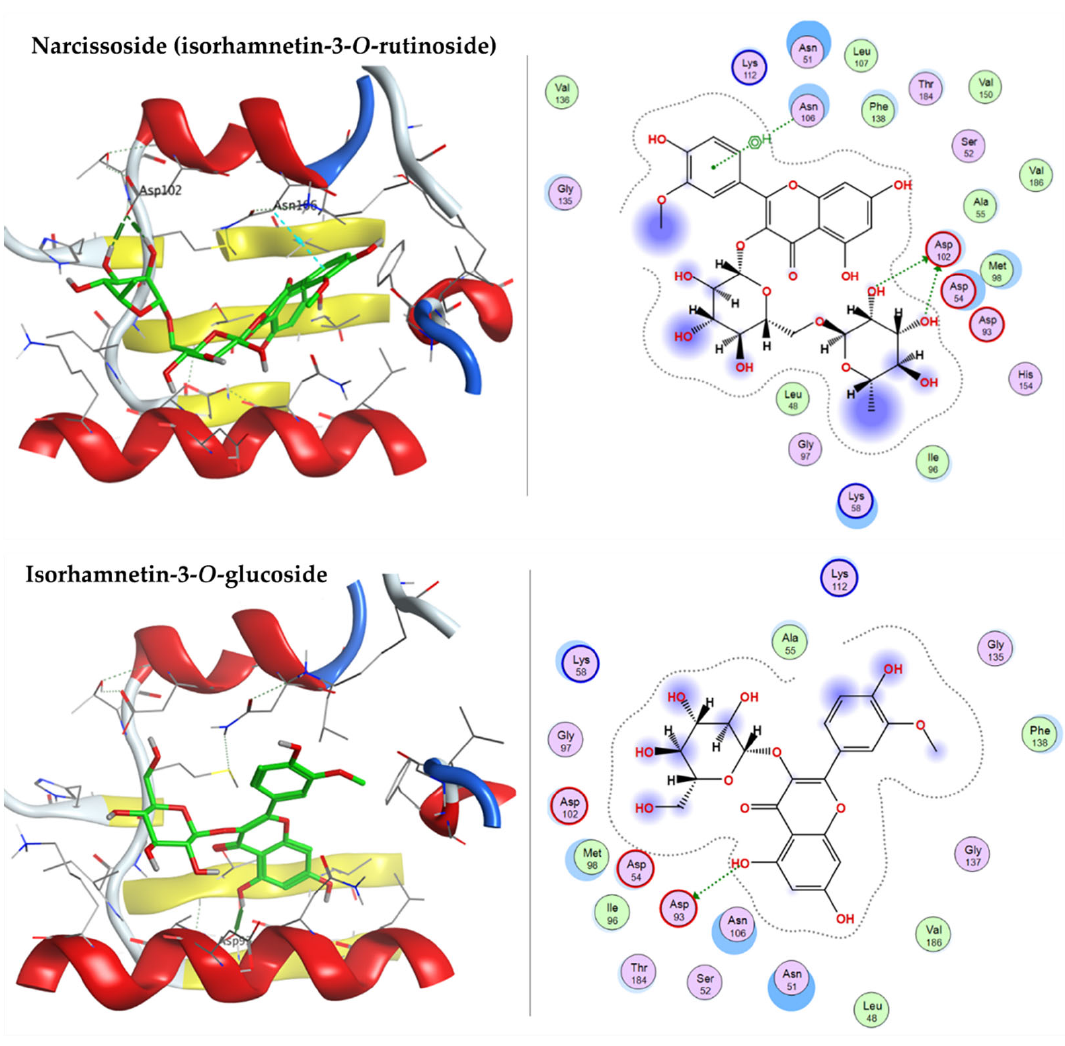
Figure 8. 3D and 2D docking plots of narcissoside (isorhamnetin ‐ 3 ‐ O ‐ rutinoside), isorhamnetin ‐ 3 ‐ O ‐ glucoside, and syringetin ‐ 3 ‐ O ‐ glucoside, respectively, on HSP90A (PDB code: 2XHX).